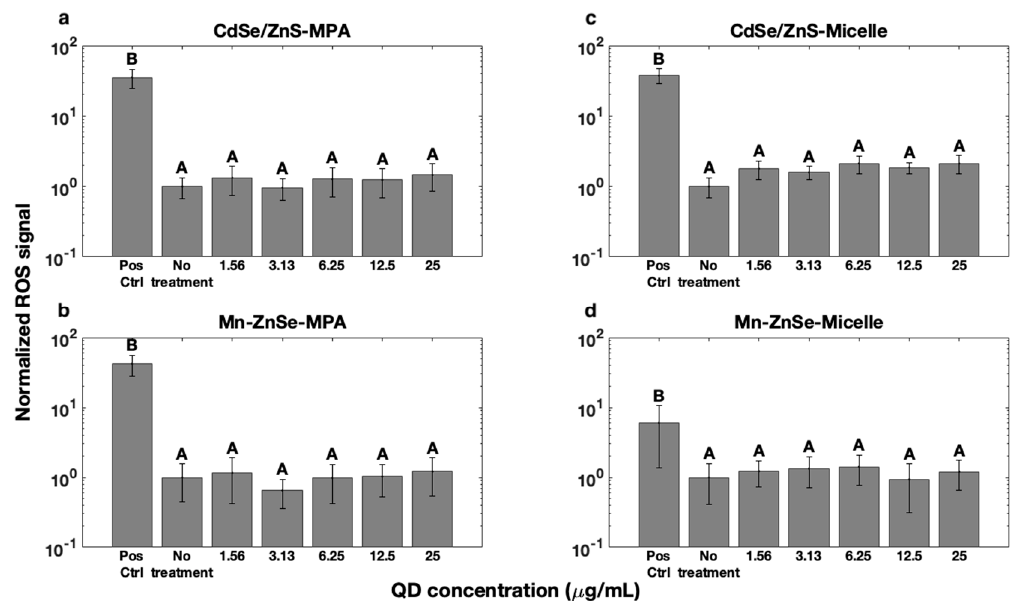
Figure 3. Assessment of ROS production for ( a , c ) CdSe/ZnS and ( b , d ) Mn-doped ZnSe QDs ( a , b ) coated with MPA surface ligands or ( c , d ) encapsulated in PS-PEO polymer micelles. Results are normalised to no-treatment, negative control groups. Menadione exposure was used as a positive control. Bars connected by different letters display statistically significant differences. Thus, bars connected by A are statistically indistinguishable from negative controls receiving no treatment, and statistically different from positive controls samples exposed to menadione (i.e., samples connected with B).